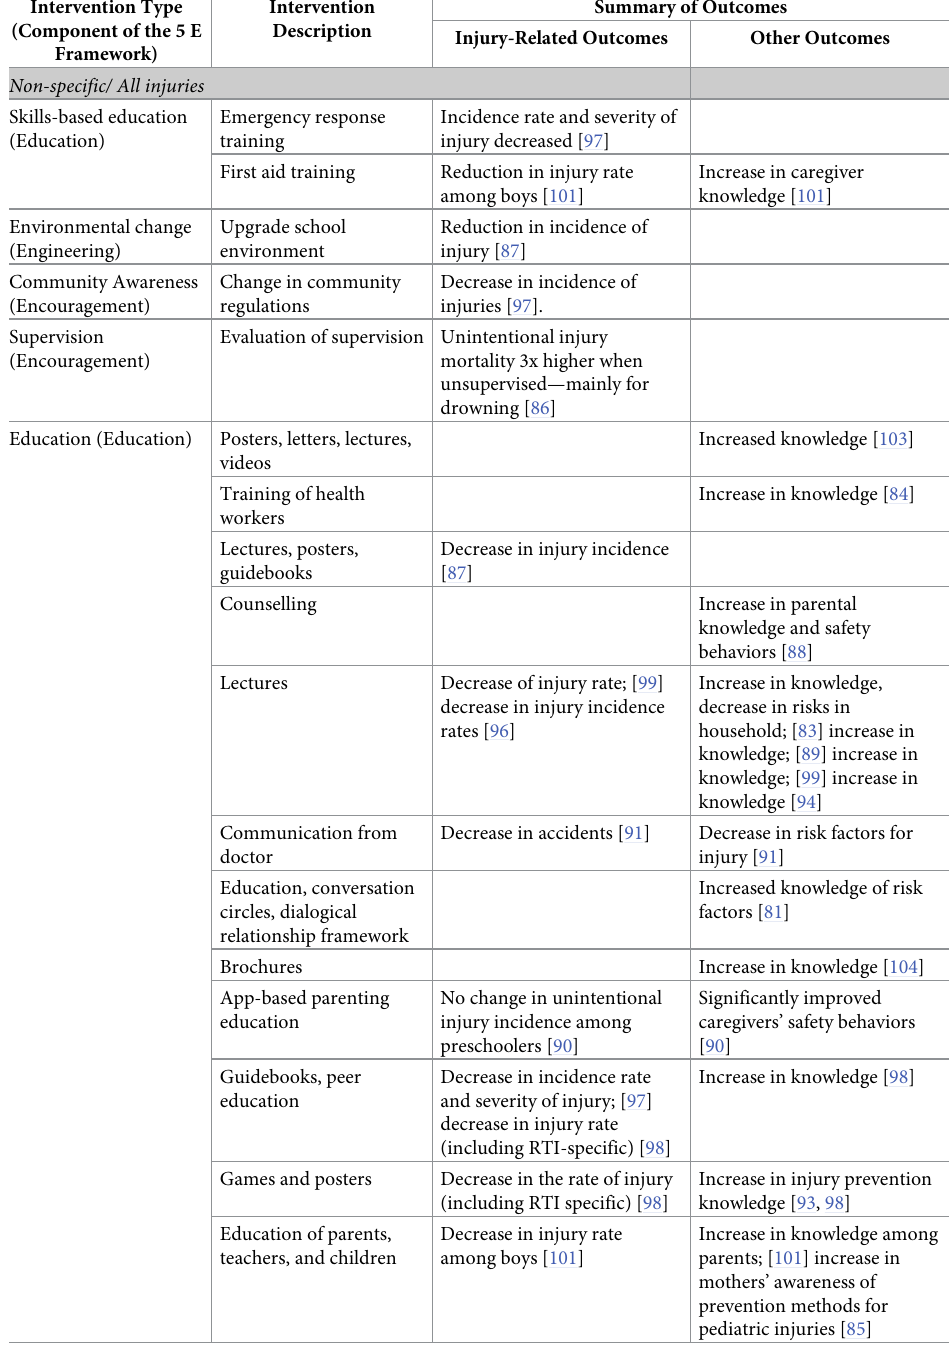
Table 6. Summary of intervention outcomes for injury types: Non-specific/all